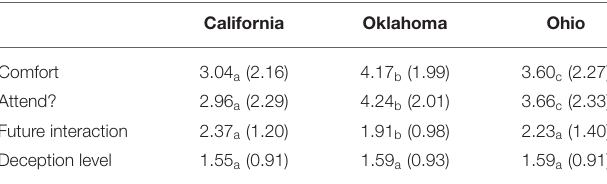
Table 3 for means and standard deviations for each location of data collection (California, Oklahoma,